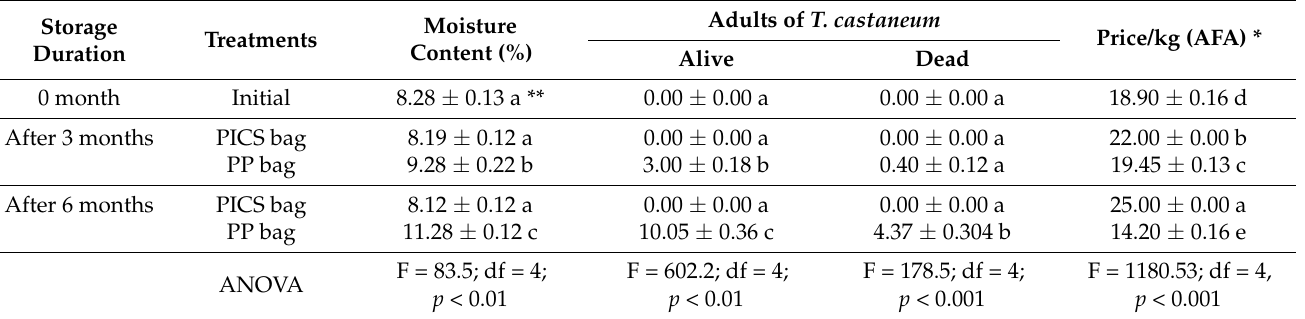
Table 2. Moisture content, insect infestation, and price (Afghani, AFA) of wheat flour stored in Purdue Improved Crop Storage (PICS) and polypropylene (PP) bags for three and six months in Herat Afghanistan. Values are means ± standard